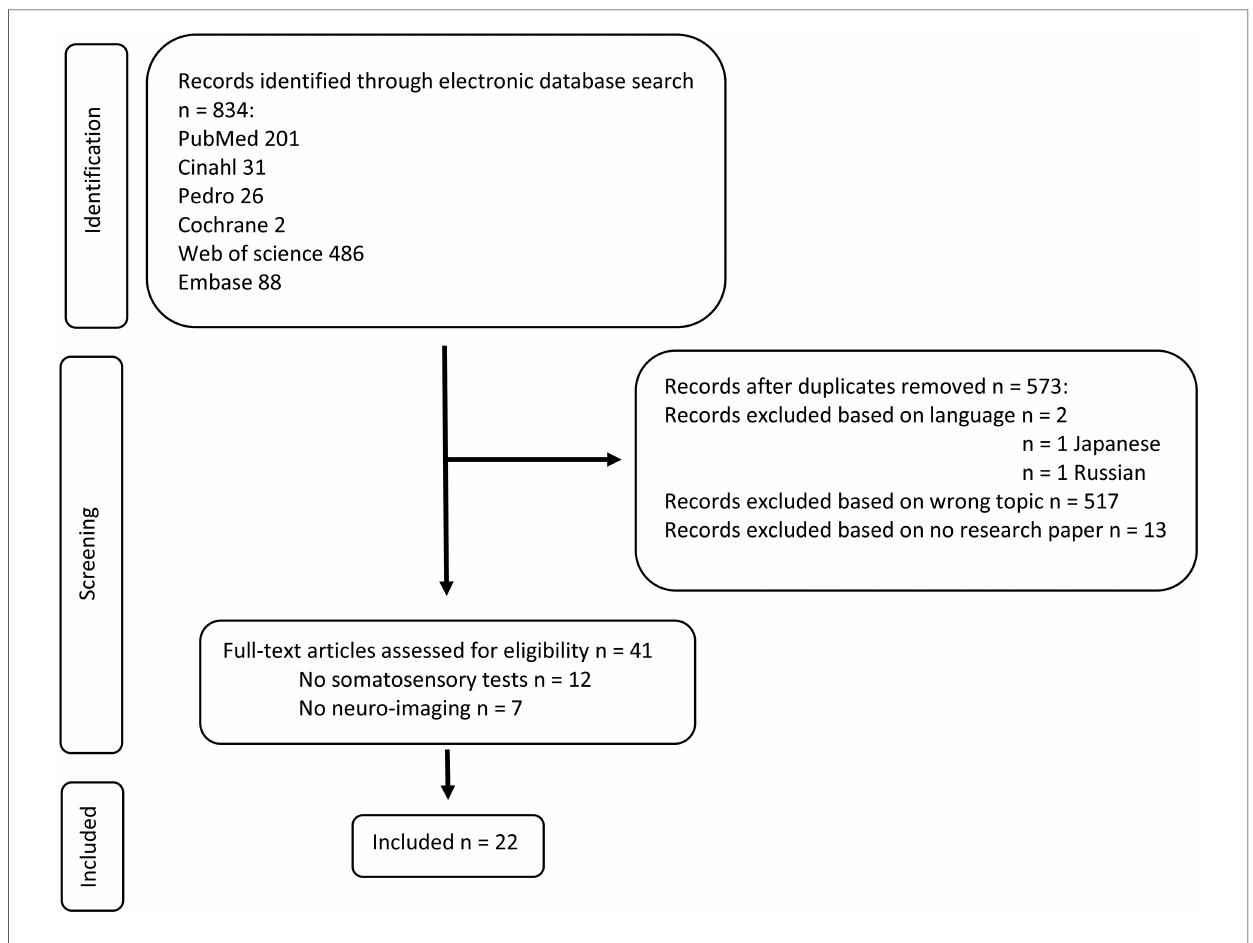
FIGURE 1 Flowchart of the study selection